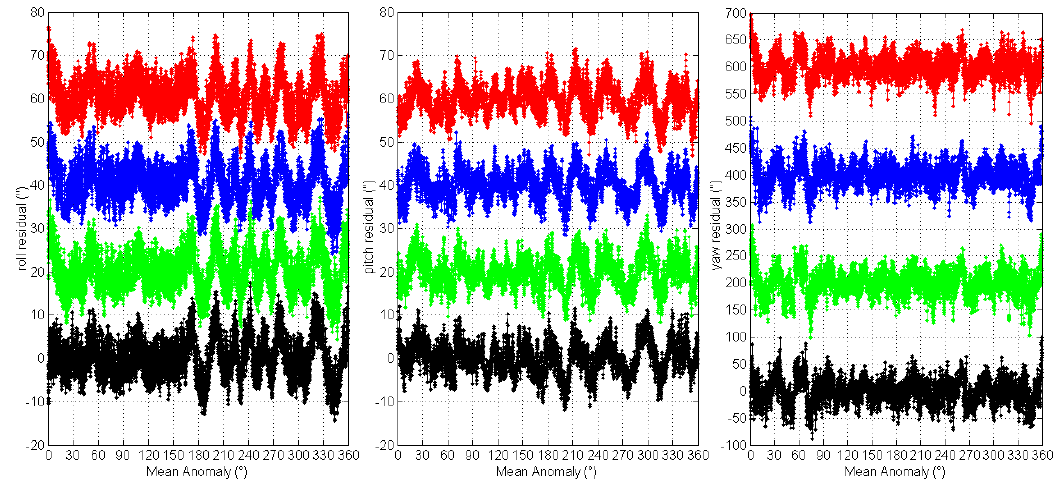
Figure 5. The 3-axes Euler angle residual streams of APS01 as time series.